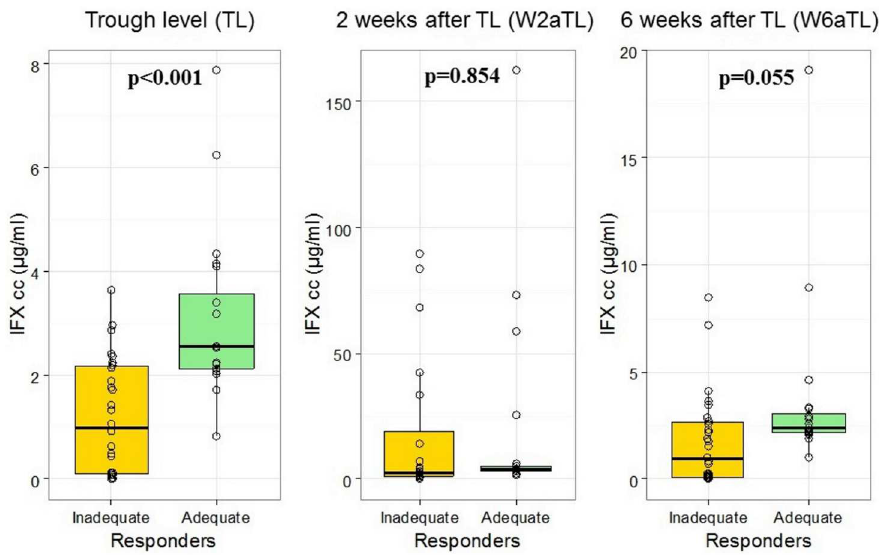
Fig 1. Serum IFX levels immediately prior the administration of regular maintenance infliximab (IFX) infusion (trough level, TL), as well as 2 (W2aTL) and 6 weeks (W6aTL) afterwards in the adequate and inadequate responder group.